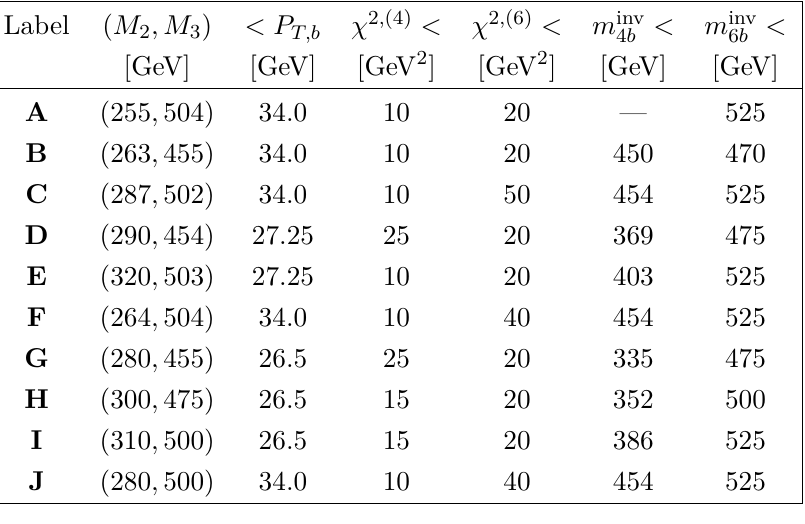
Table 3 . The optimised selection cuts for each of the benchmark points within BP3 shown in table 2. The cuts not shown above are common for all points, as follows: | η |